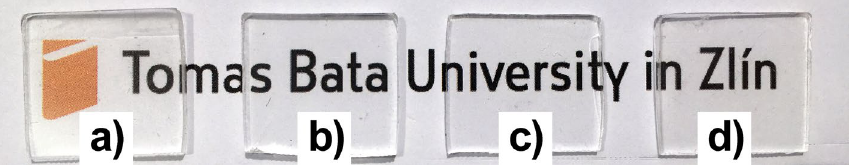
Figure 1. Digital photograph of the prepared silicone elastomers with the portion of Sylgard 184:silicone oil. ( a ) 10:0, ( b ) 9:1, ( c ) 8:2, and ( d ) 7:3.